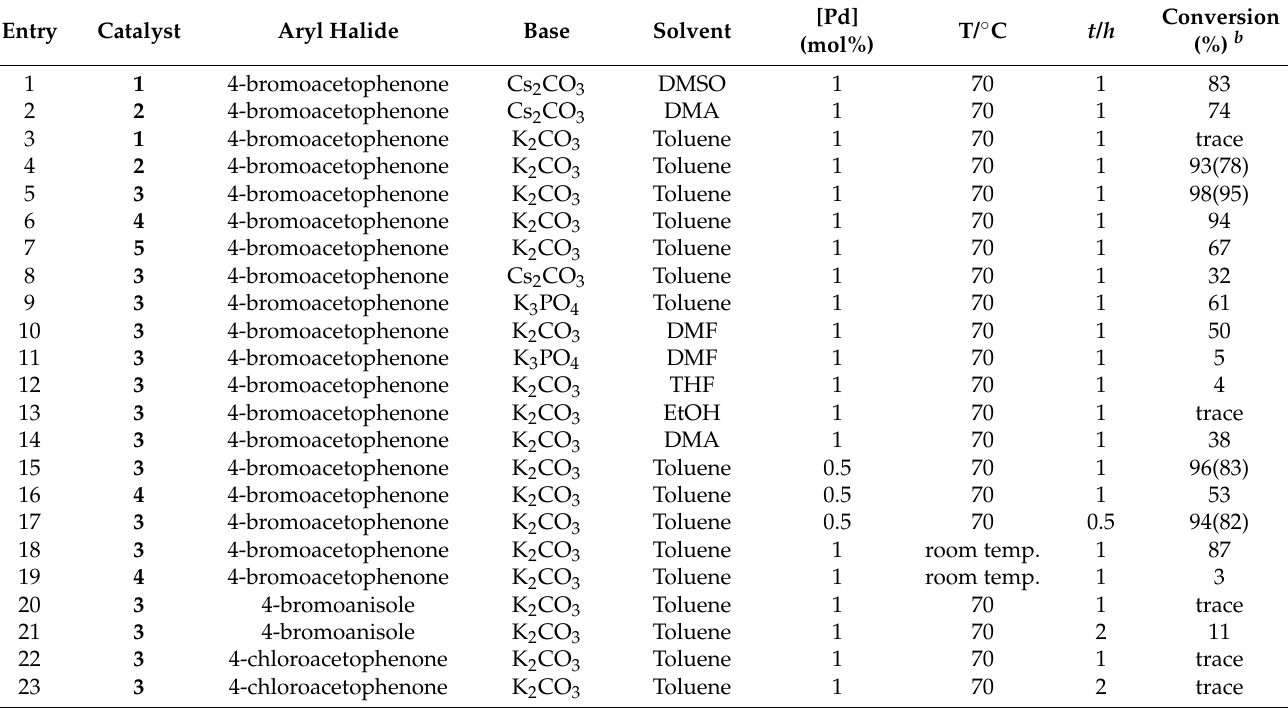
Scheme 2. Application of the palladium indolyl complexes in the Suzuki reaction. Table 2. Suzuki coupling reaction catalyzed by new palladium complexes a Table 2. Suzuki coupling reaction catalyzed by new palladium complexes a .